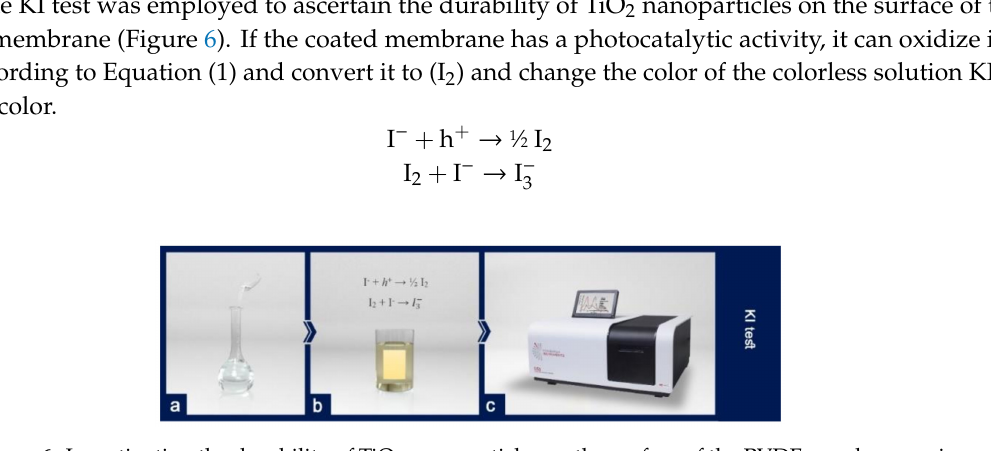
Figure 6. Investigating the durability of TiO 2 nanoparticles on the surface of the PVDF membrane using the KI test: ( a ) preparing the KI solution; ( b ) the change in the color of the colorless solution by entering the TiO 2 –PVDF membrane; ( c ) the UV-Vis spectrophotometer to show the solution wavelengths.